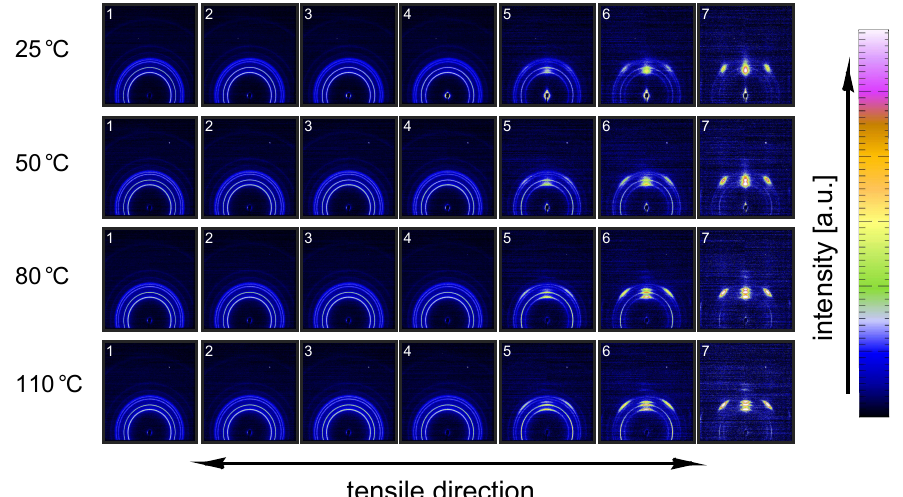
Figure 15. Normalized 2D-patterns of γ -iPP stretched at temperatures of 25, 50, 80 and 110 ◦ C from top to bottom. The true strains, determined with the assumption of fully uni-axial deformation, are given as well. The macroscopic strains at which the patterns were taken are indicated by the markers in Figure 8. The stretching direction is